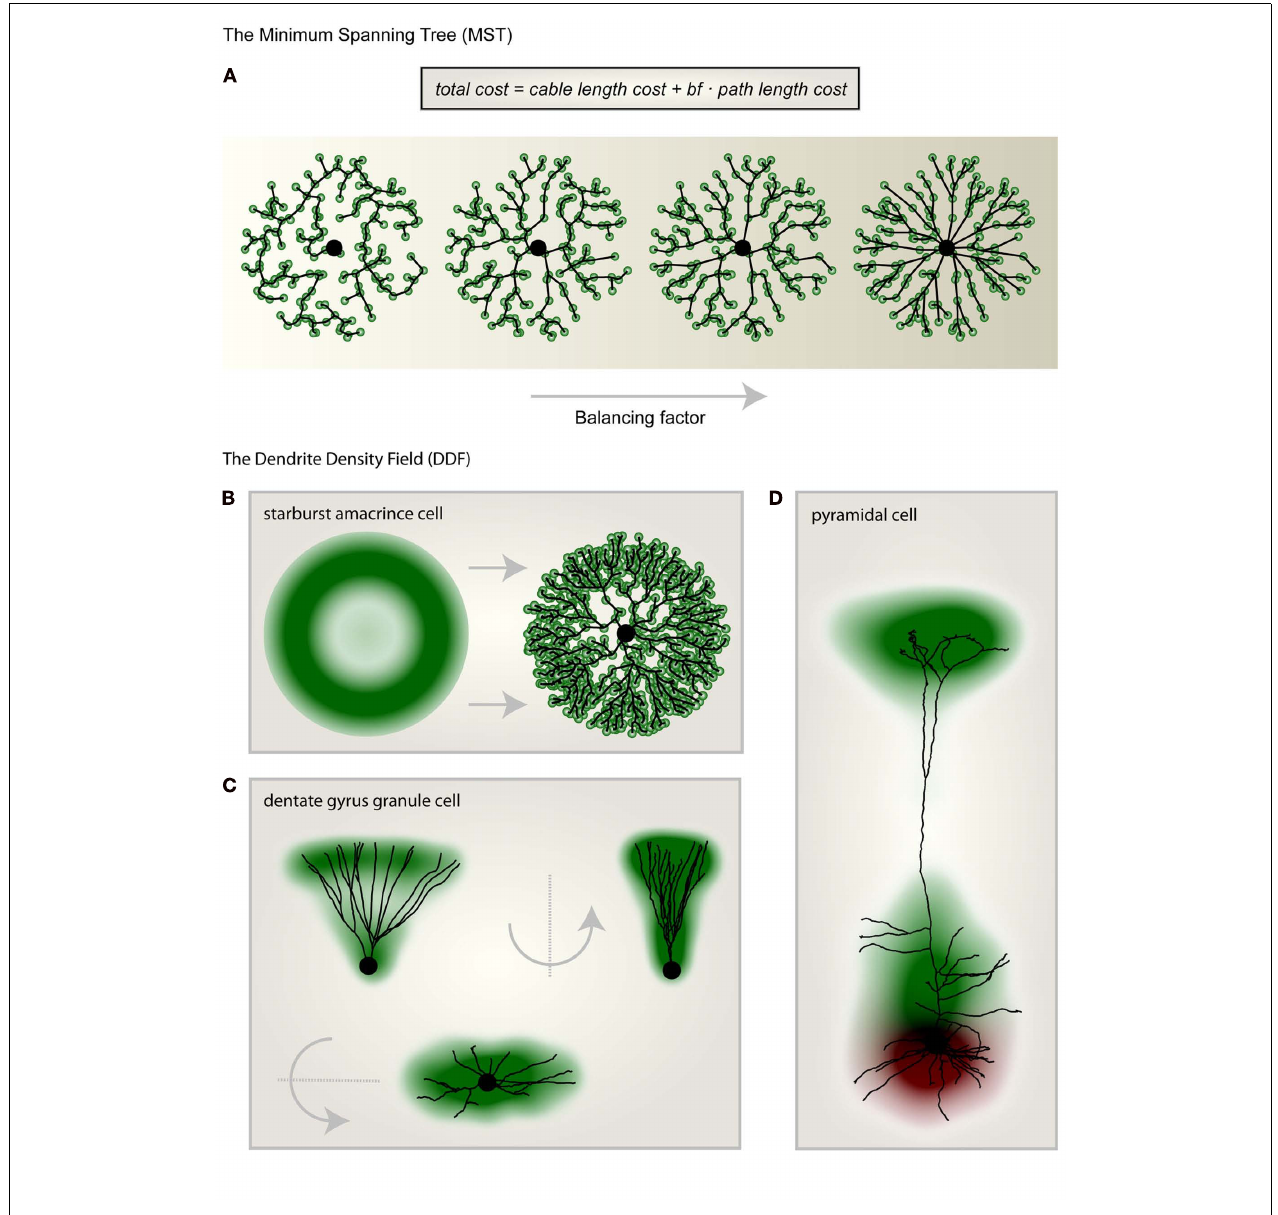
connecting them using the MST algorithm (right) to a starting node (large black dot), a synthetic starburst amacrine cell dendrite can be generated. (C) The DDF obtained directly from reconstructions of dentate gyrus granule cells with its characteristic cone-like shape. A representative real morphology is shown. (D) Separate DDFs for L5 cortical pyramidal cell basal trees (red) and apical trees (green). One representative real morphology is shown. Parts of the figure were adapted from Cuntz et al.